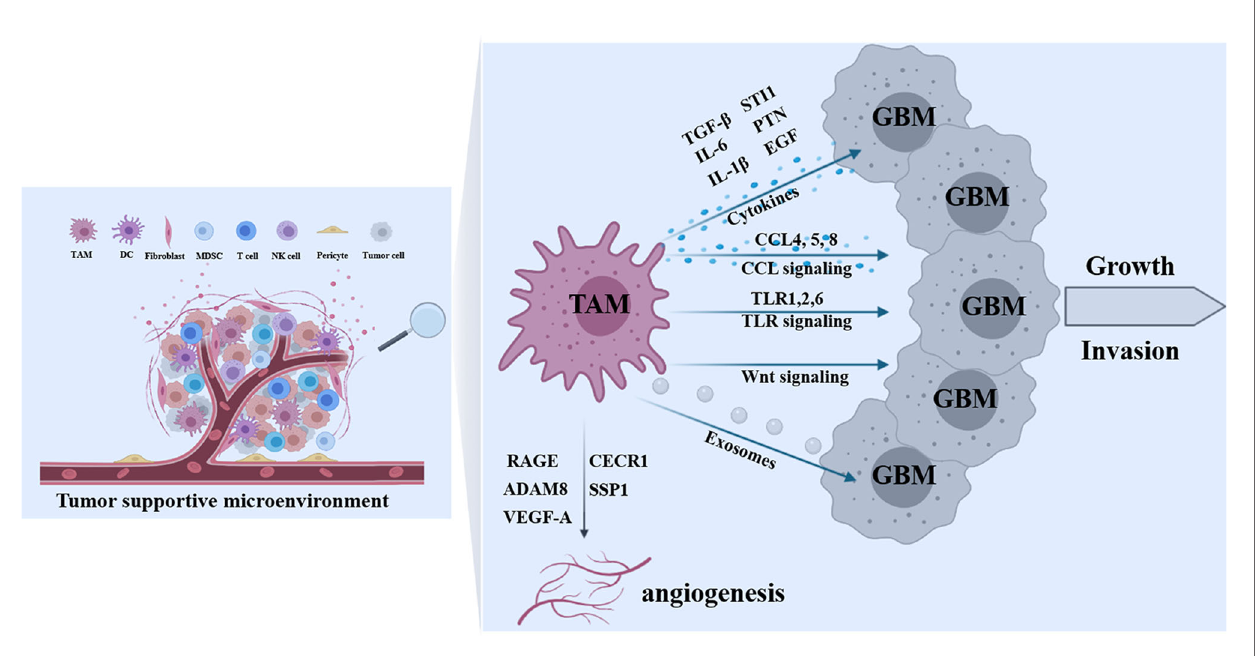
FIGURE 3 | Effects of TAMs on tumor progression. In the tumor-supportive microenvironment of GBM, a variety of TAMs-derived factors contribute to tumor growth and invasion including cytokines (TGF- b , IL-6, IL-1 b , STI1, PTN, and EGF), molecules in CCL signaling (CCL4, 5 and 8), proteins in TLR signaling (TLR1,2 and 6), Wnt signal cascades, and TAM-derived exosomes. In addition, some TAMs-derived molecules (RAGE, ADAM8, CECR1, SSP1, and VEGF-A) are implicated in tumor